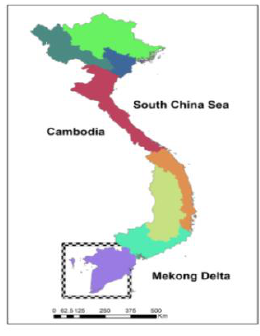
Figure 1. Vietnam map showing the location of the study area (Mekong Delta,